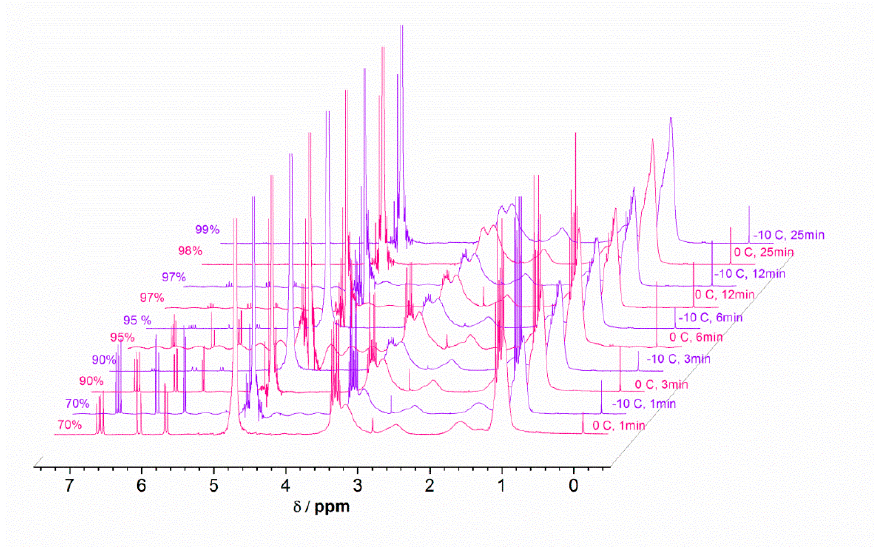
Figure 6. 1 H NMR spectra for Cu(0)-mediated polymerization of DEA in H 2 O at 0.0 °C and − 10 °C